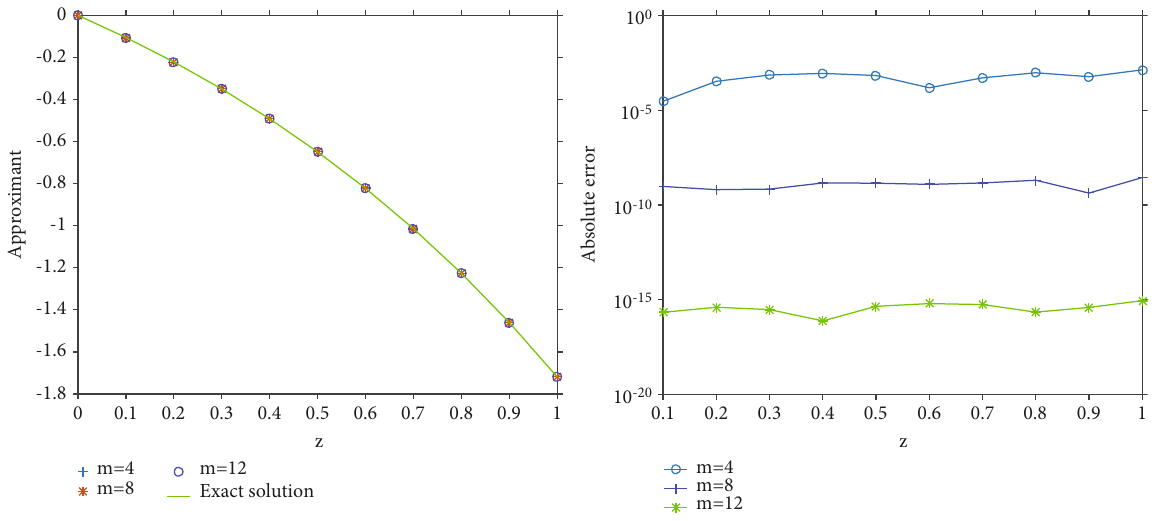
Figure 3: Approximate solutions and its absolute Table 4: Absolute maximum errors for Example 4 at di ff erent degrees of approximation m .